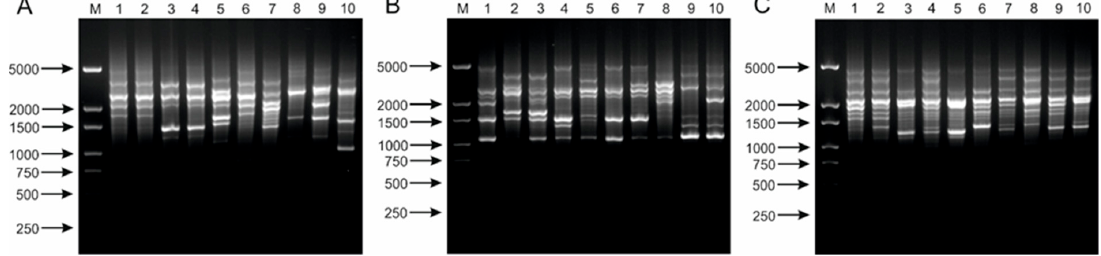
Figure 4. (GTG) 5 -PCR patterns of 30 strains belonging to L. casei group. Analysis of the discriminatory power of the procedure applied was performed for 10 strains of L. casei ( A )—M, DNA molecular